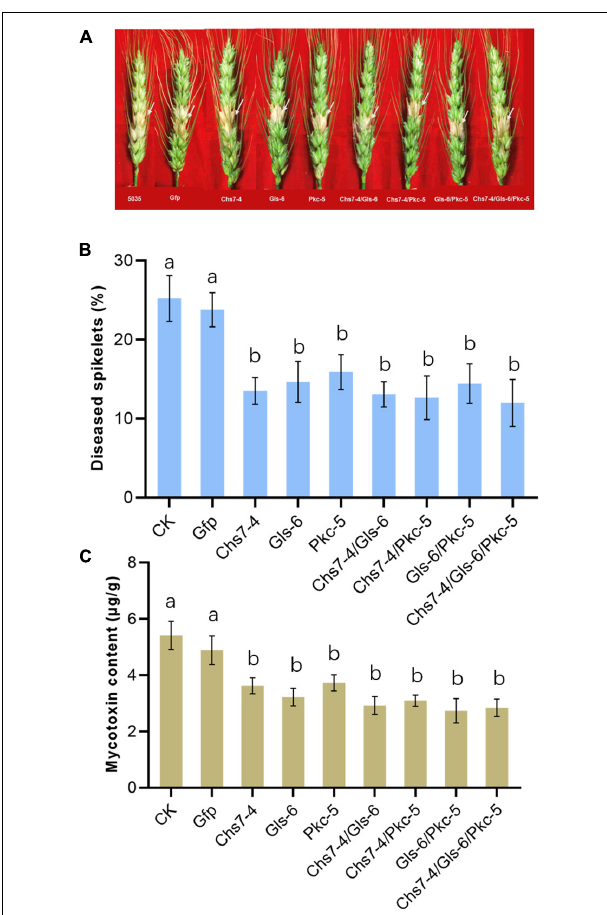
FIGURE 5 | (A-C) Disease symptoms, scores and mycotoxin contents of different dsRNA treatments and controls after inoculation with Fusarium graminearum . Phenotypes of representative wheat Fusarium head blight at 14 dai are in the top of the panel, the disease scores, expressed as percentages of infected spikelets are in the middle of the panel, and mycotoxin contents of the grains are in the bottom of the panel. Error bars indicate SE of two independent experiments. Different letters indicate statistical significance ( p < 0.01;